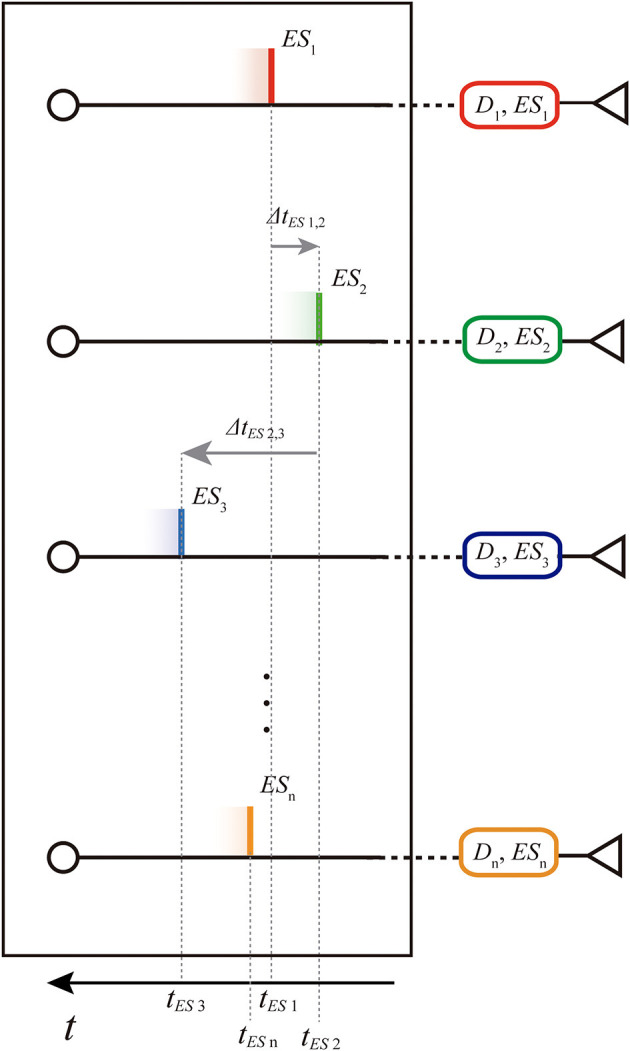
Representation of the spike train shown in Figure 2 on the entryway of the structure: absolute spike times (tES1, tES2,., tESn) and relative intervals (ΔtES1, 2, ΔtES2, 3, ..., ΔtESn−1, n). Note that the time axis is reversed since we are representing the parallel spike train in motion toward right.